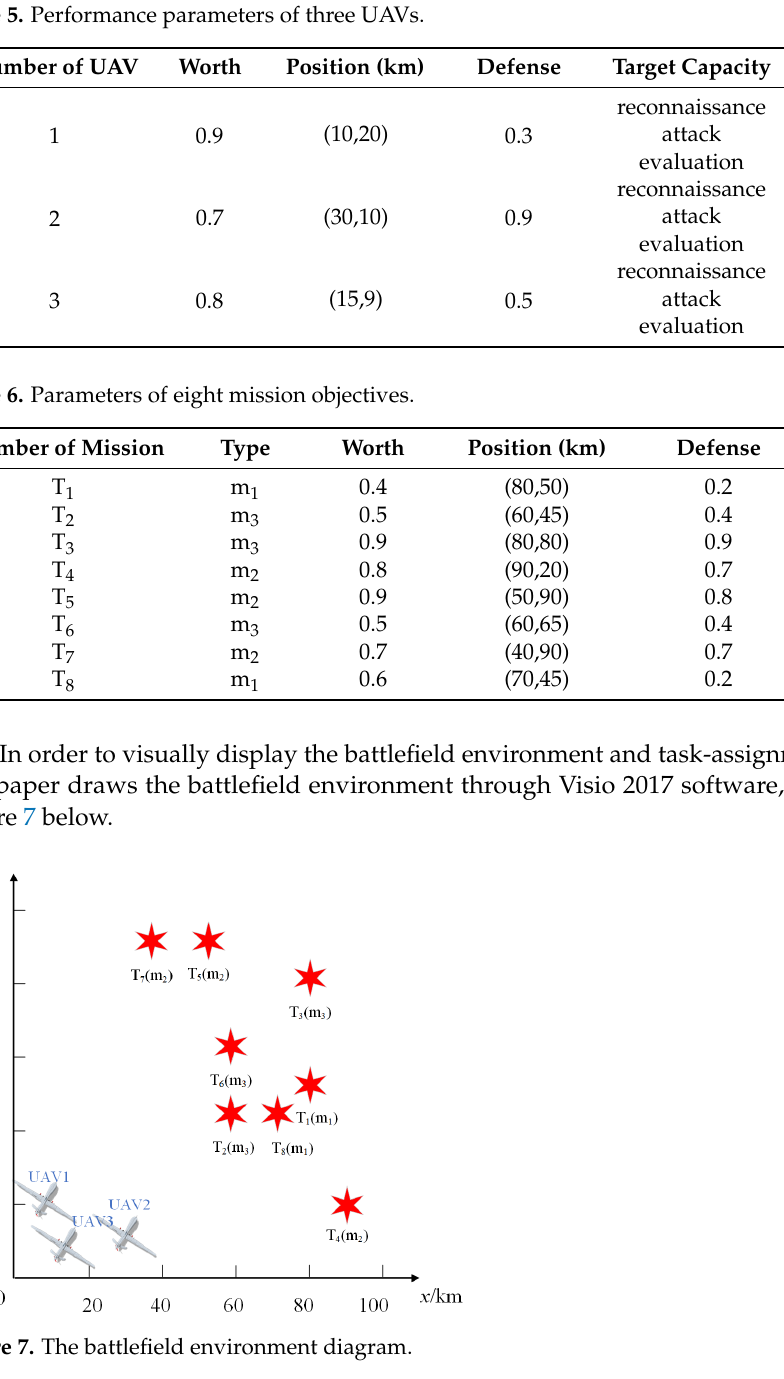
10 times. The solution results are shown in Table 7, where Tar _ fitness _ final represents the final task fitness; the higher the fitness, the better the feasible solution iterated by the algorithm. P represents the success rate of the algorithm solution, and Mean is the average of the solution results obtained 10 times for each